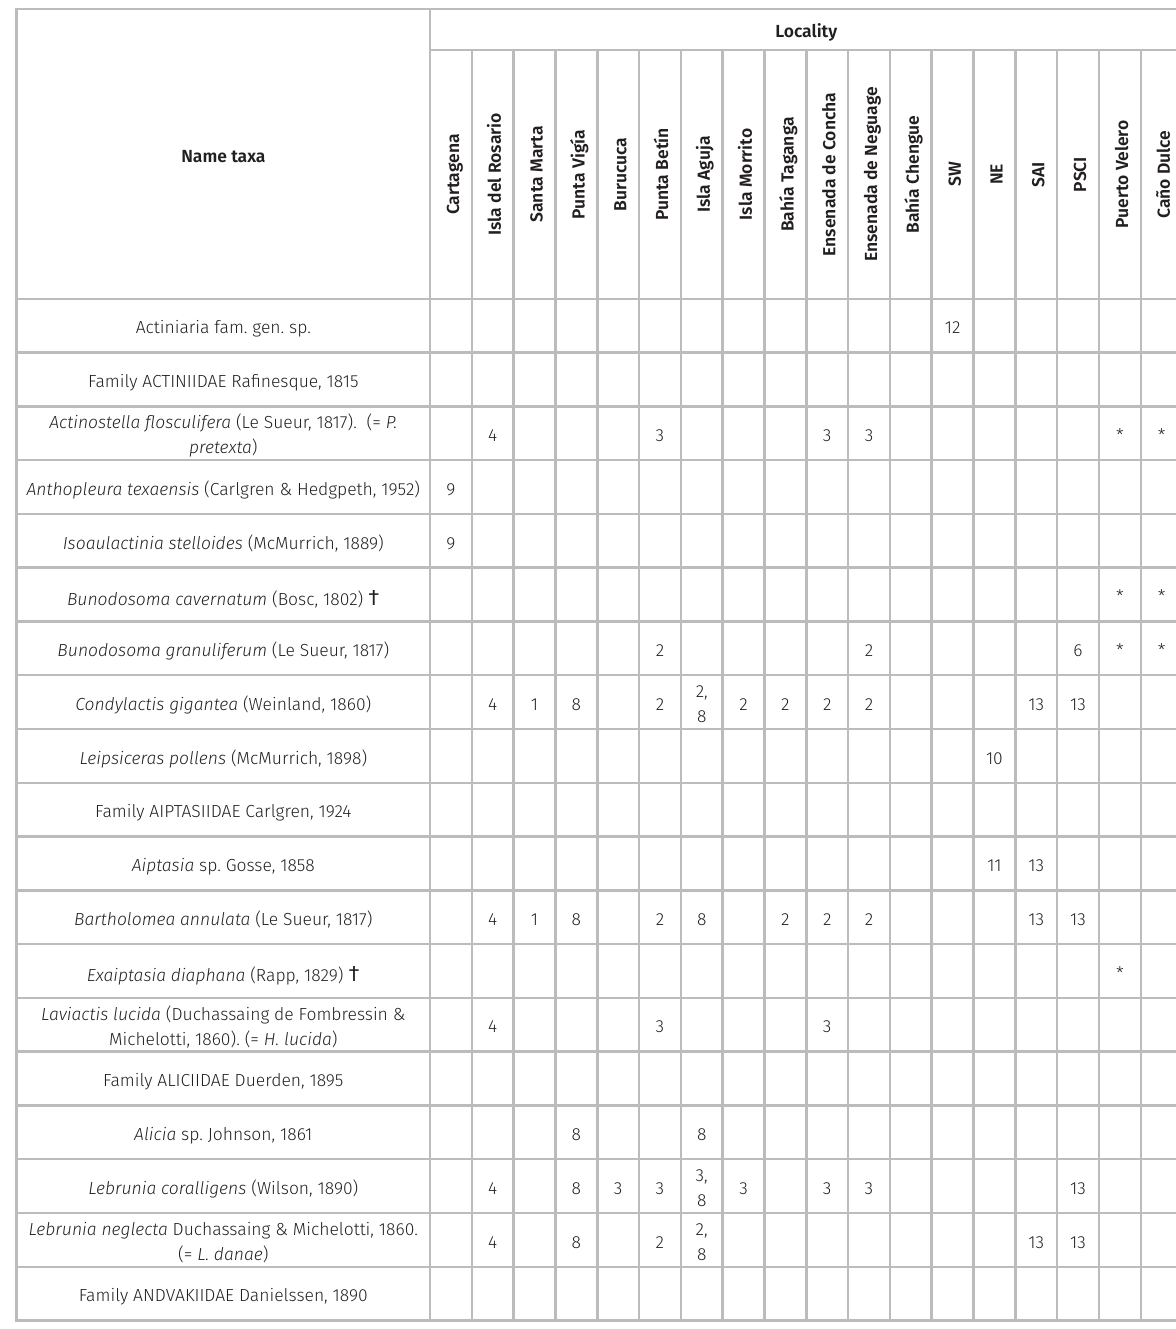
Table I. Previous and new records of actiniarian species in the Colombian Caribbean. Species are listed alphabetically by family and species. The symbol “*” indicate new records for the locality found in the present study, “†” indicates new records for the Colombian Caribbean, and the citations of “1-13” indicates localities of previously published records. Abbreviation: (SW) South-western and (NE) North-eastern Colombian Caribbean, (SAI) San Andrés Island and (PSCI) Providencia and Santa Catalina Islands. Citation: 1- Riemann-Zürneck 1972; 2- Manjarrés 1977; 3- Manjarrés 1978; 4- Manjarrés 1979; 5- Brattström 1980; 6- Werding et al. 1981; 7- Reyes & Campo 1992; 8- Barrios-Suárez et al . 2002; 9- Daly & Den Hartog 2004; 10- Flórez & Sandodomingo 2010; 11- Gracia et al. 2013; 12- Dueñas et al. 2019; 13- SIMB